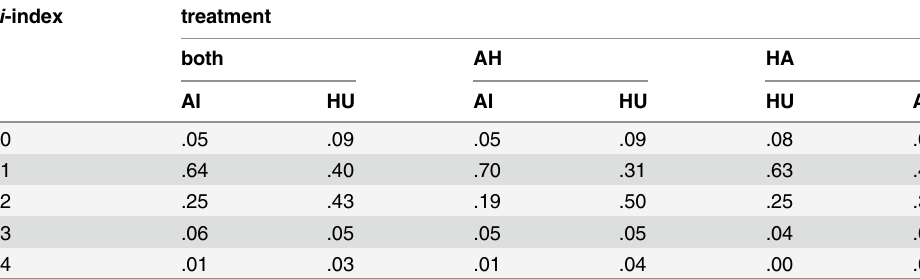
Table 9. The i -index for the df games by treatment and version. i